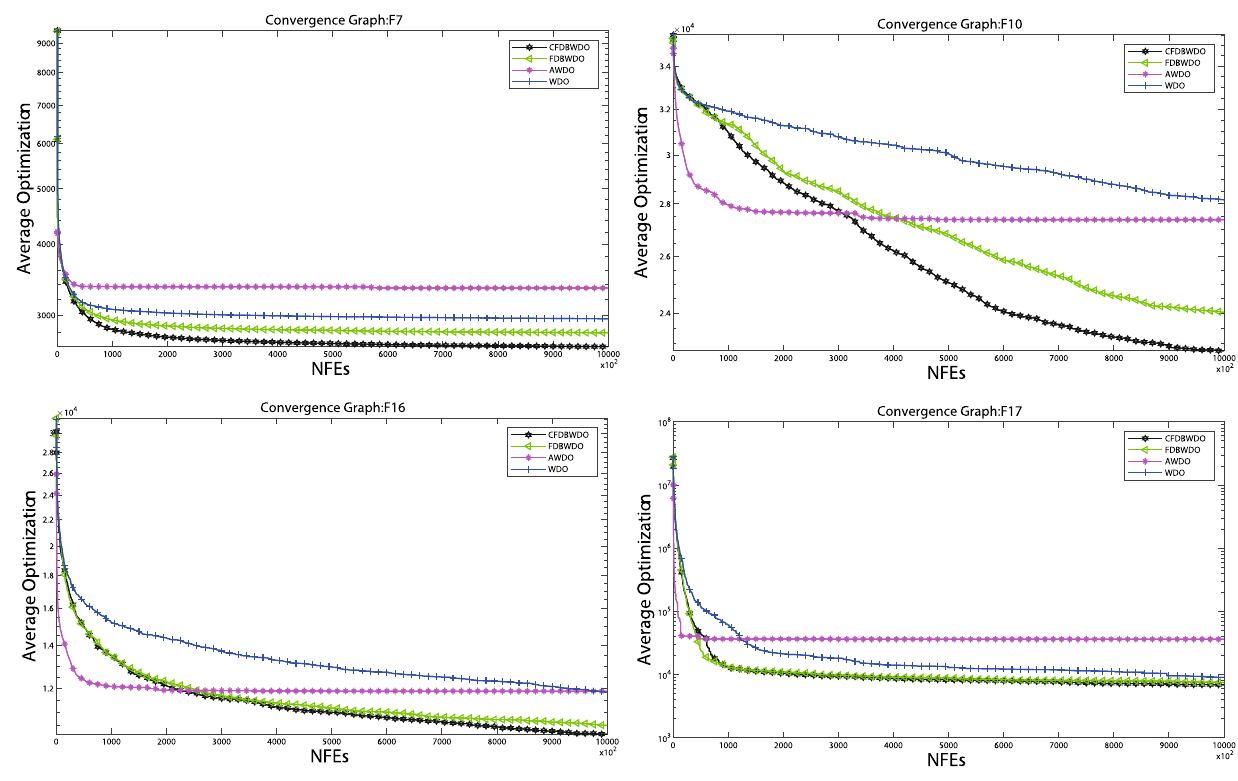
Fig. 10 Convergence graphs of four WDO variants on F7, F10, F16 and F17 with 100